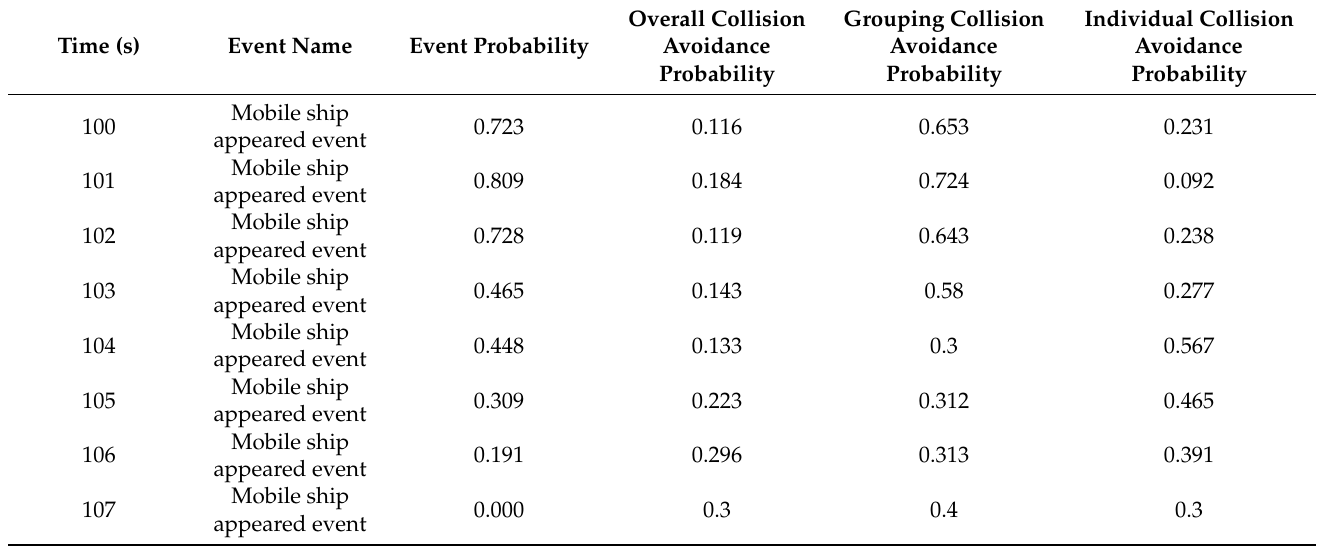
Table 3. Cooperative perception output results.